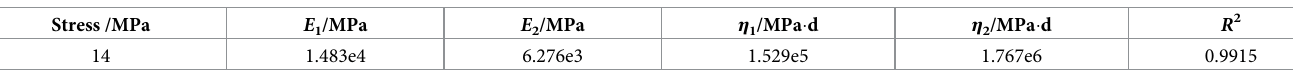
Table 2. Identification table of model parameters in stable creep